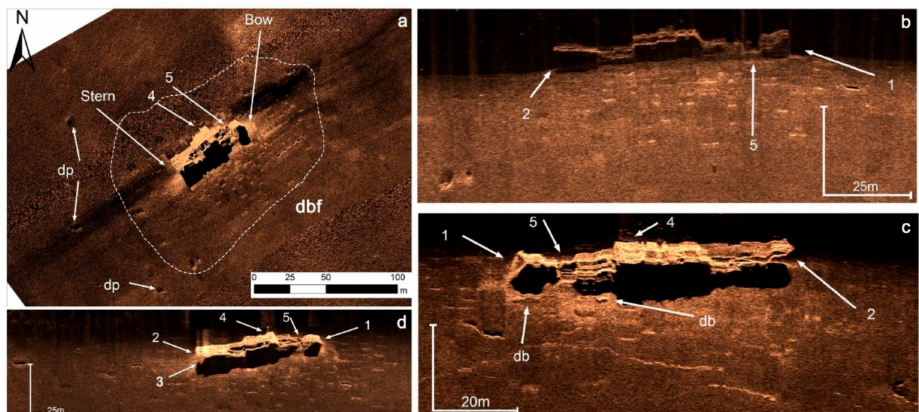
Figure 8. ( a ) Regional 100 kHz sonograph showing the “pump house” wreck and its environment (dbf: debris field, db: wreck debris, dp: seabed depressions). ( b – d ) 500 kHz sonographs showing the main structural components of the “pump house” wreck (1: vertical bow or “plumb”, very common during the past half of the 19th century and the first decades of the 20th in merchant ships; 2: stern, 3: propellers; 4: bridge and 5: heavy damage on the